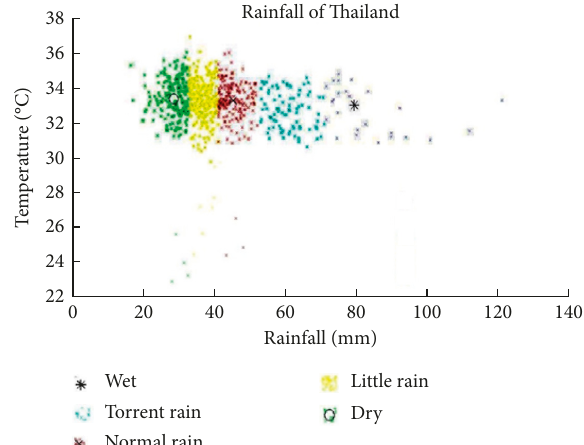
Figure 1: The volume of rainfall and the ranges of temperatures. Source: Thailand Meteorological Department